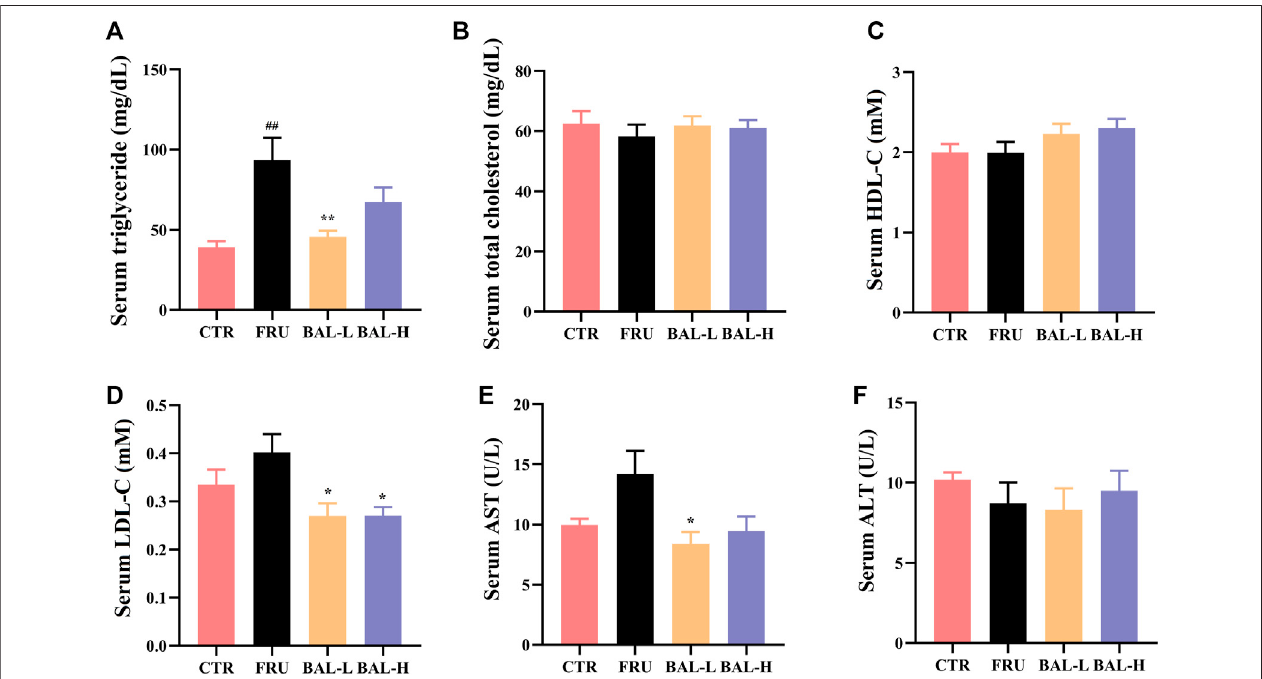
FIGURE 1| The serum biochemical indexes of rats during BAL treatment. (A) Serum TG. (B) Total TC in serum. (C) HDL-C in serum. (D) Serum LDL-C. (E) Serum level of AST. (F) ALT level in serum. Data were represented as Mean ± SEM (n ≥ 6/group), ## p < 0.01 , # p < 0.05 , compared with CTR; **p < 0.01 , *p < 0.05 , compared to